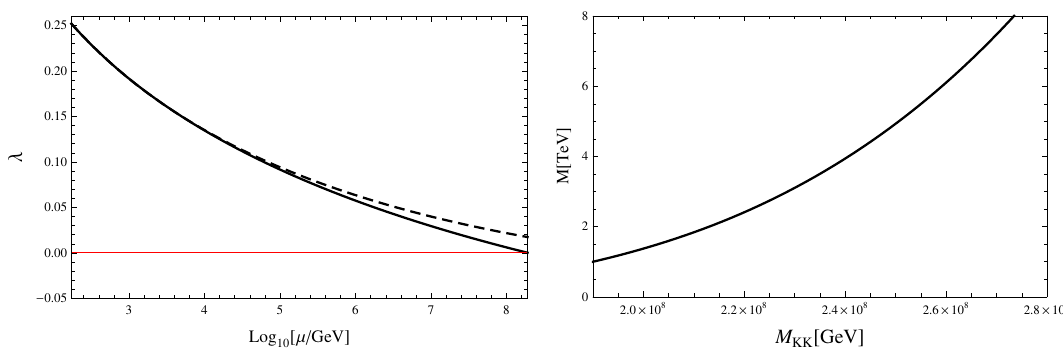
Figure 3 . Left panel: RG evolution of the Higgs quartic coupling with the bulk mass M =1 TeV (solid line), along with the result in the SM (dashed line). The compactification scale is found to be M KK = 1 . 9 10 8 GeV, where the gauge-Higgs condition λ ( M KK ) = 0 and × g 2 ( M KK ) / √ 2 are satisfied. Right panel: the relation between the bulk mass ( M ) and the compact- ification scale ( M KK ) so as to reproduce the 125 GeV Higgs boson